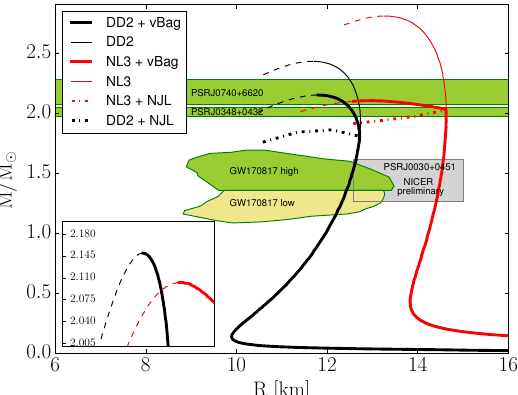
10 − 6 MeV − 2 ) with different hadronic ×